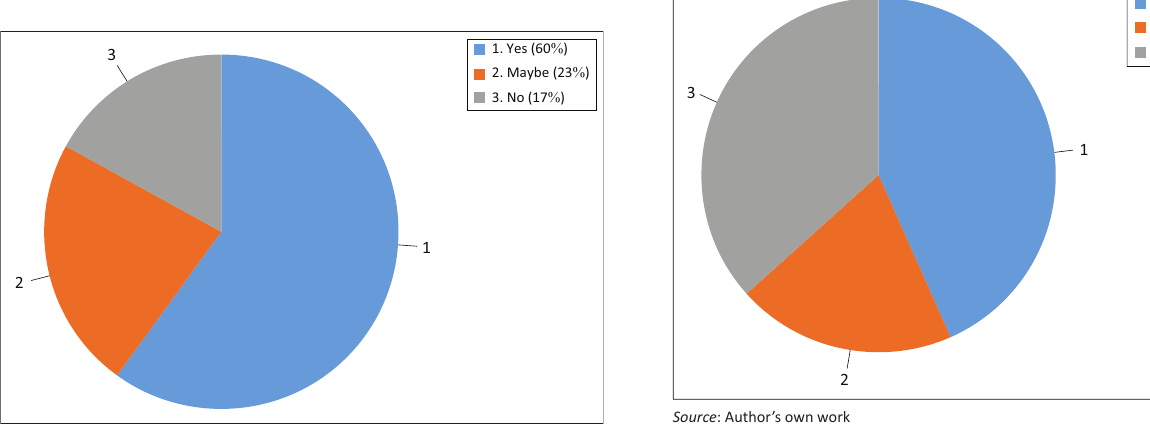
FIGURE 2: Exposure to the notion of multilingualism in the course of studies: In the course of your studies in the journalism programme, do you recall being exposed to the term ‘multilingualism’ ( % )?